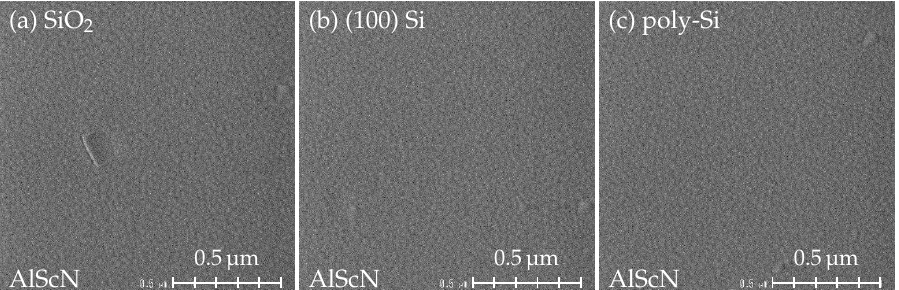
Figure 3. SEM surface view of 500nm AlScN grown on ( a ) SiO 2 , ( b ) (100) Si and ( c ) poly-Si with a 20nm AlN seed layer.